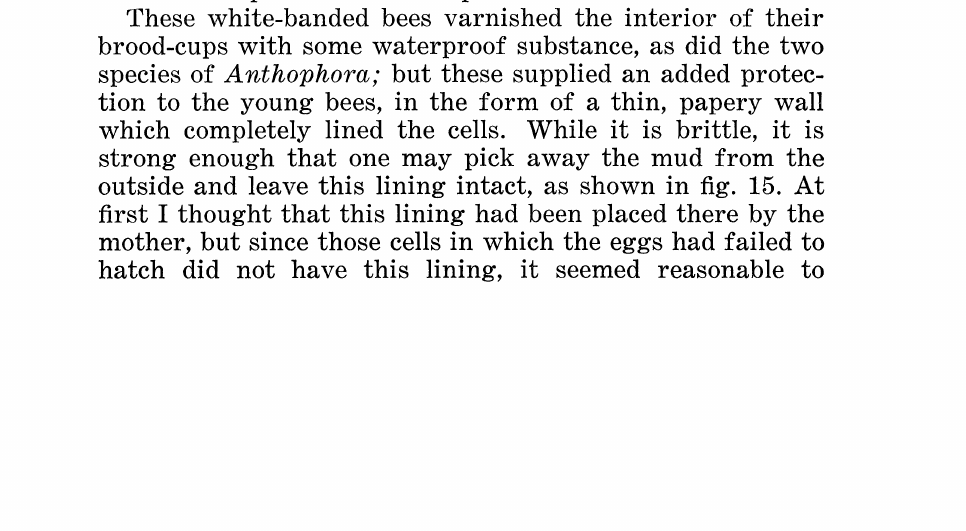
Fig. 15. The brood cup of E. taurea, with the mud wall cut away to show the intact papery